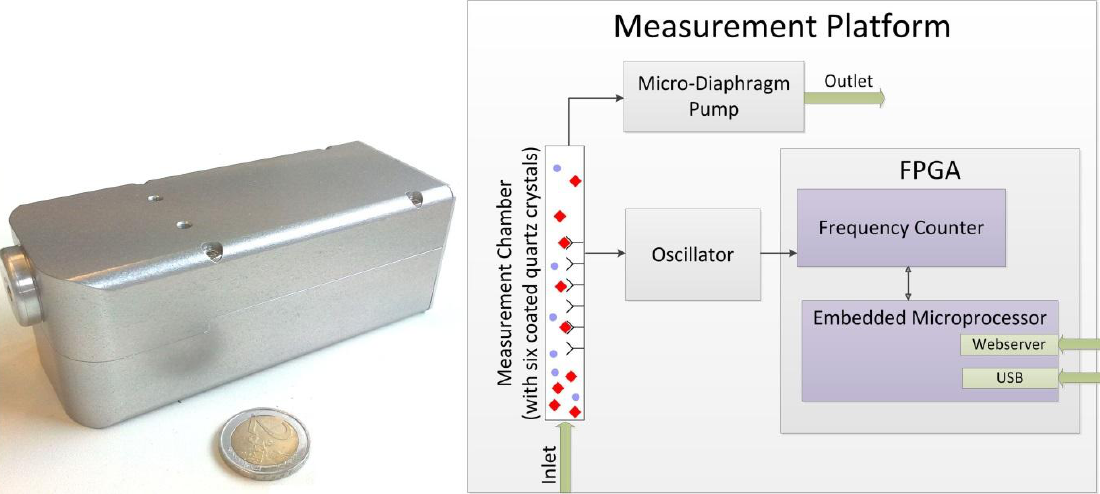
Figure 1. Prototype of the handheld measurement platform and schematic description of the measurement